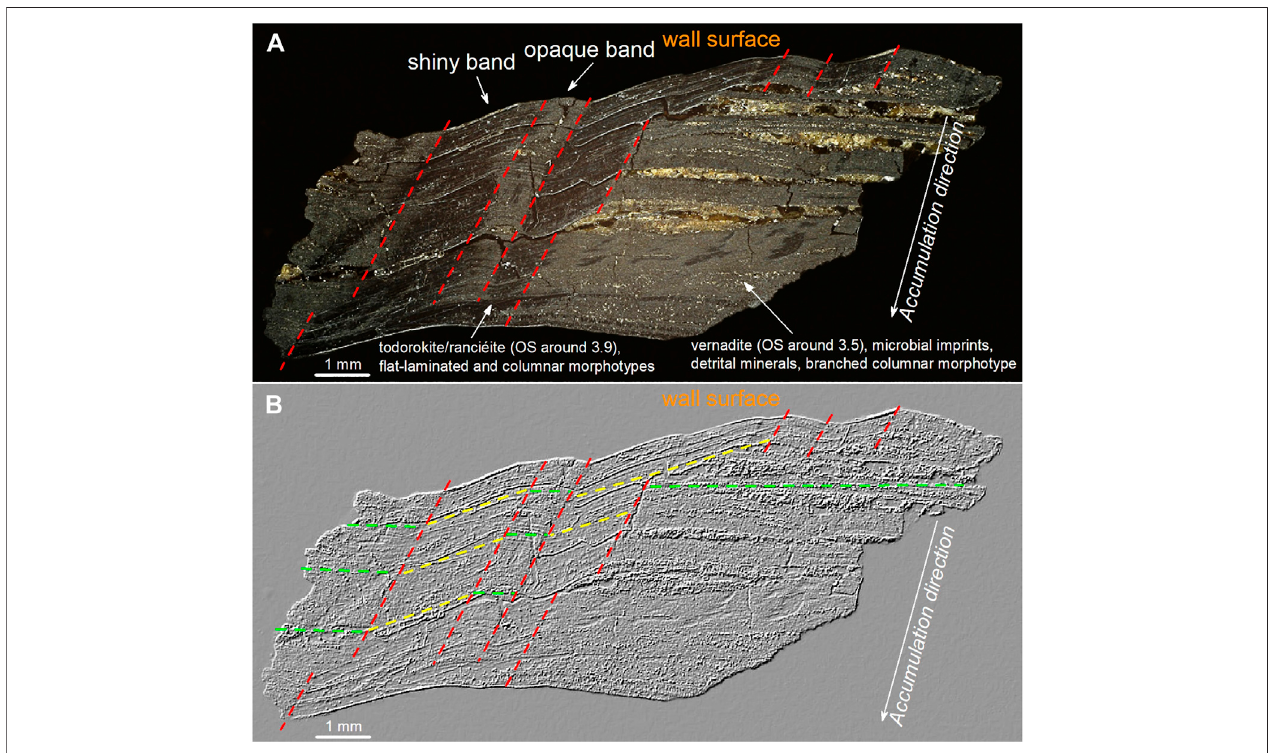
FIGURE 13 | Optical microscope image of sample GC (A) , and after directional fi ltering for linear enhancement (B) . These images show the distribution of shiny bands (associated whit layers transversely oriented, todorokite/ranciéite (OS ∼ 3.9), and planar forms produced in a more turbulent “ local ” environment) and opaque bands (associated withlayershorizontallyoriented, vernadite(OS ∼ 3.5),microbialimprints,detrital minerals, andforms produced inalessturbulent “ local ” environment, allowing the microbial community to stay attached to the wall surface). These bands alternate laterally, decreasing in number (from 7 to 2) along the accumulation direction of the patinas, as the surface becomes fl atter. All the features point to strong control of the wall surface geometry ( i.e., roughness) on the spatial distribution of morphology, detrital mineral abundance, mineralogy of MnOx, and oxidation state of Mn. OS: average oxidation state of Mn.